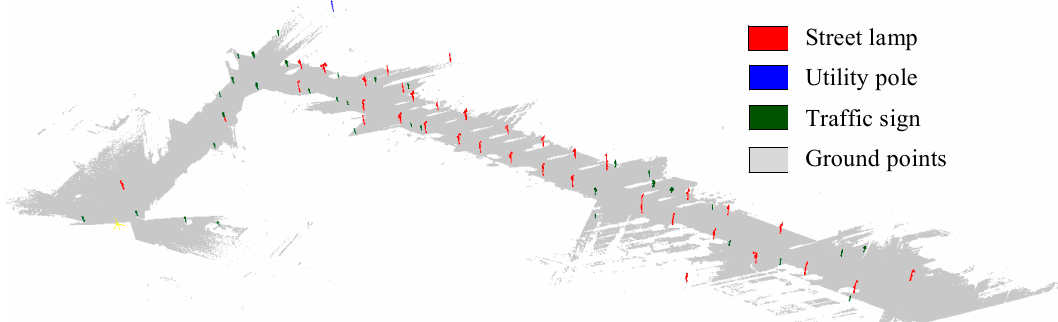
Figure 14. Results of PLO recognition in Data II. Different colors represent different classes. Figure 15. Results of PLO recognition in Data II. Different colors represent different